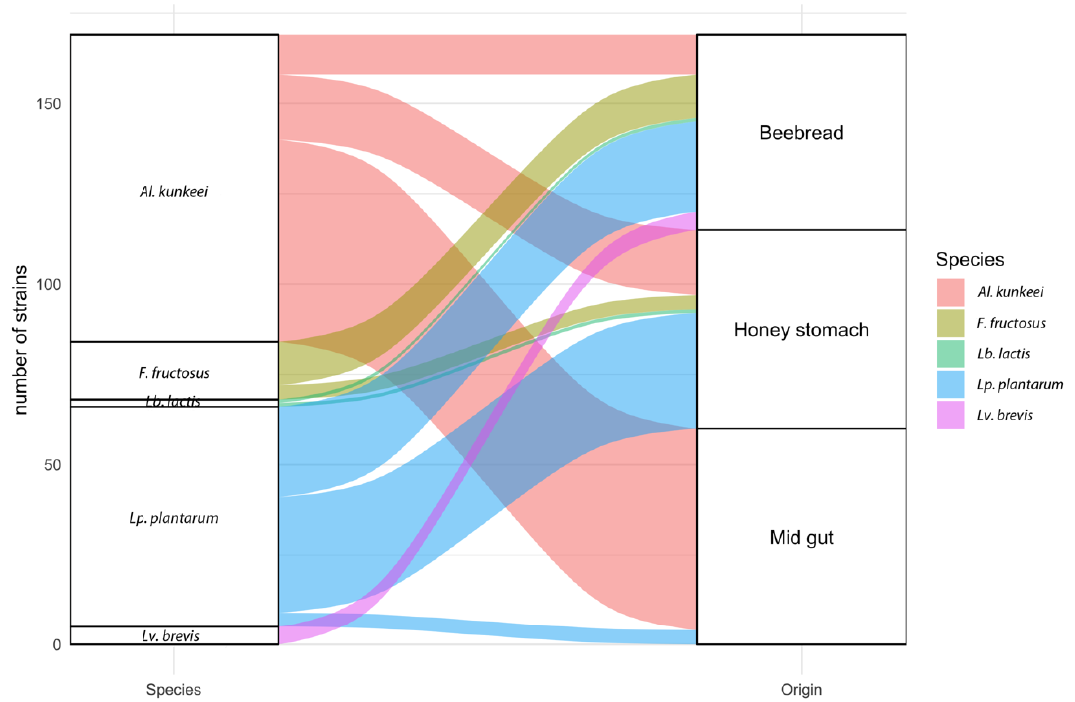
Figure 2. Alluvial plot showing the frequency of strains belonging to the five lactic acid bacteria species isolated from the beebread, honey stomach and midgut. The sizes of the boxes used for bacteria and boxes used for sources of isolation is proportional to the number of isolates present in the compartments (54 strains in beebread, 55 in honey stomach and 60 in midgut).